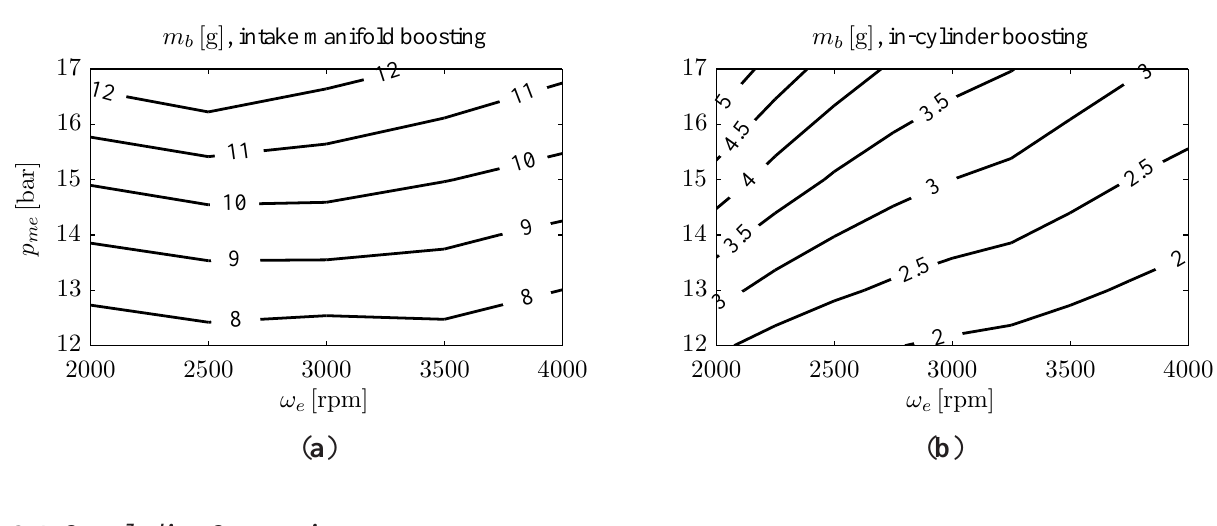
Figure 11. Simulation results for the consumed air mass m load steps from 1.7 bar p intake manifold boosting; ( b ) With in-cylinder boosting (values taken from